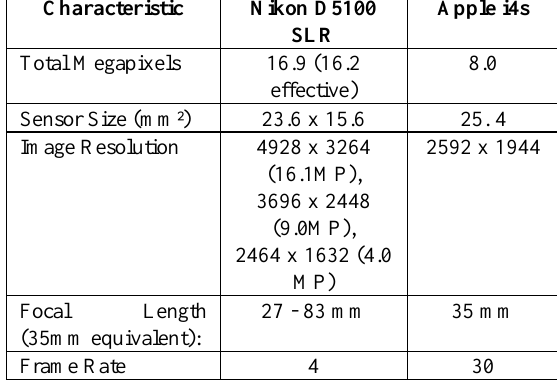
Table 2. Characteristics of Nikon D5100 SLR and Apple i4s